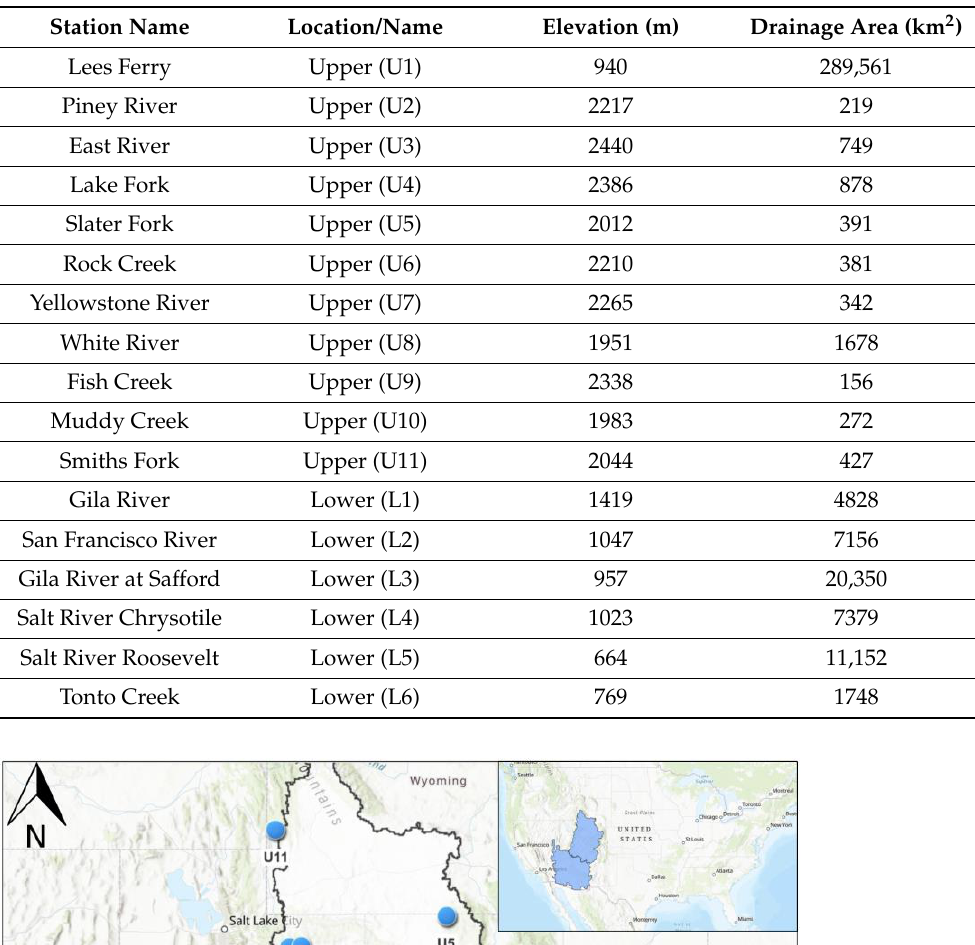
Table 1. List of Stations with characteristics.